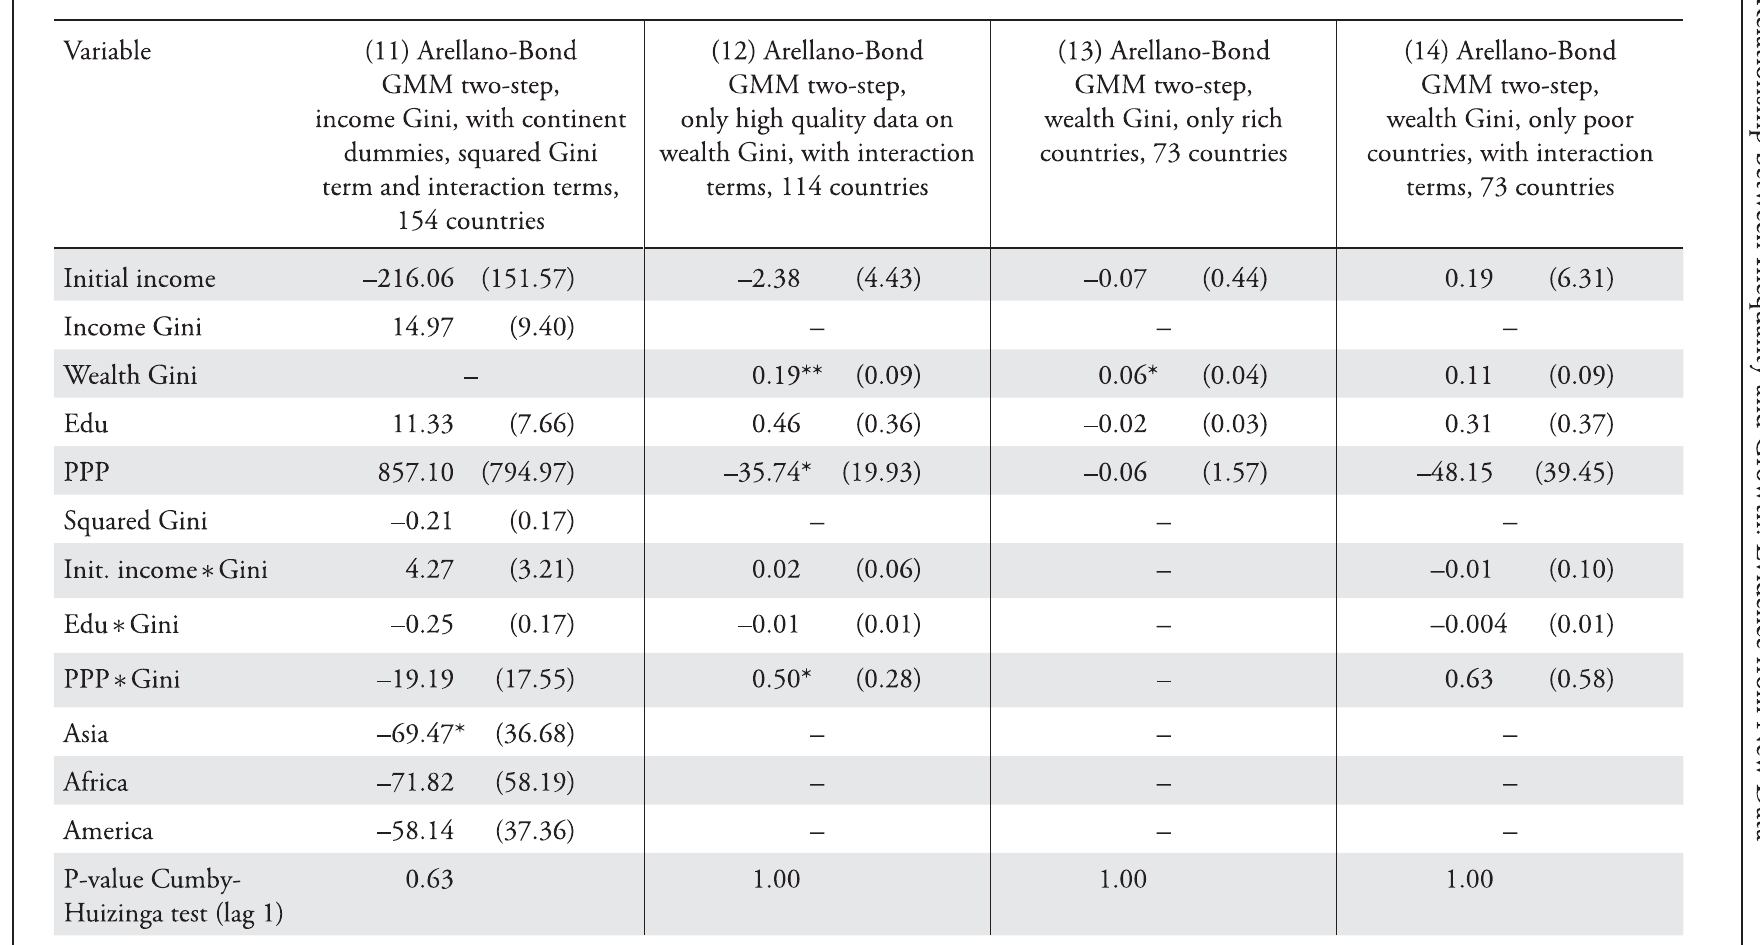
Table 7: Robustness Check